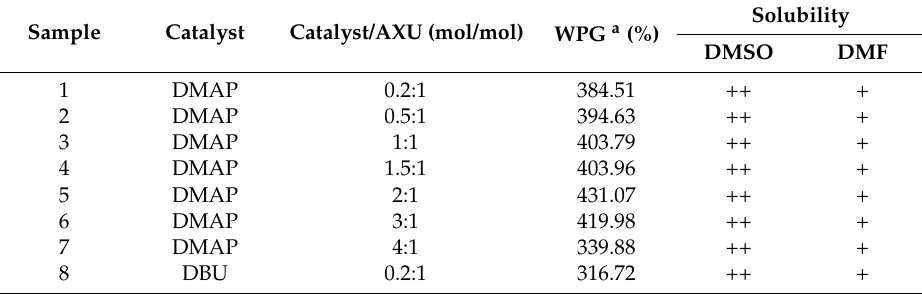
Table 1. Detailed structural factors of xylan- g -PPDO copolymers under various reaction conditions. Sample